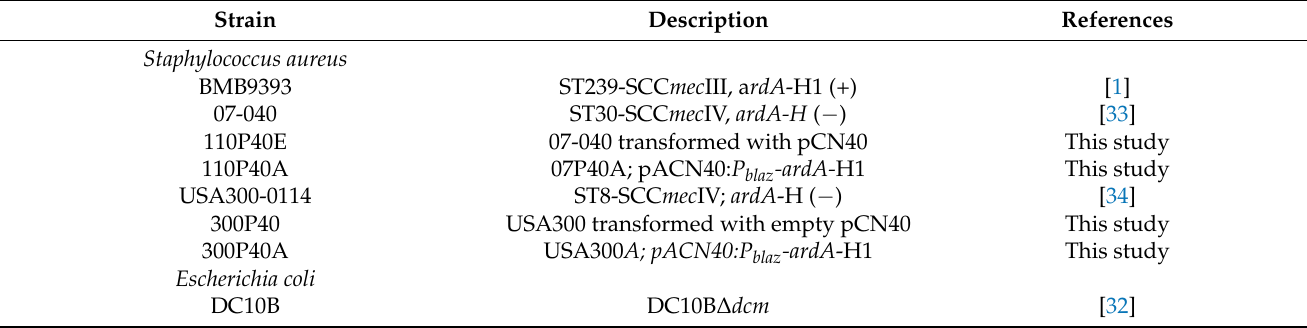
Table 1. Bacterial strains used in this study.